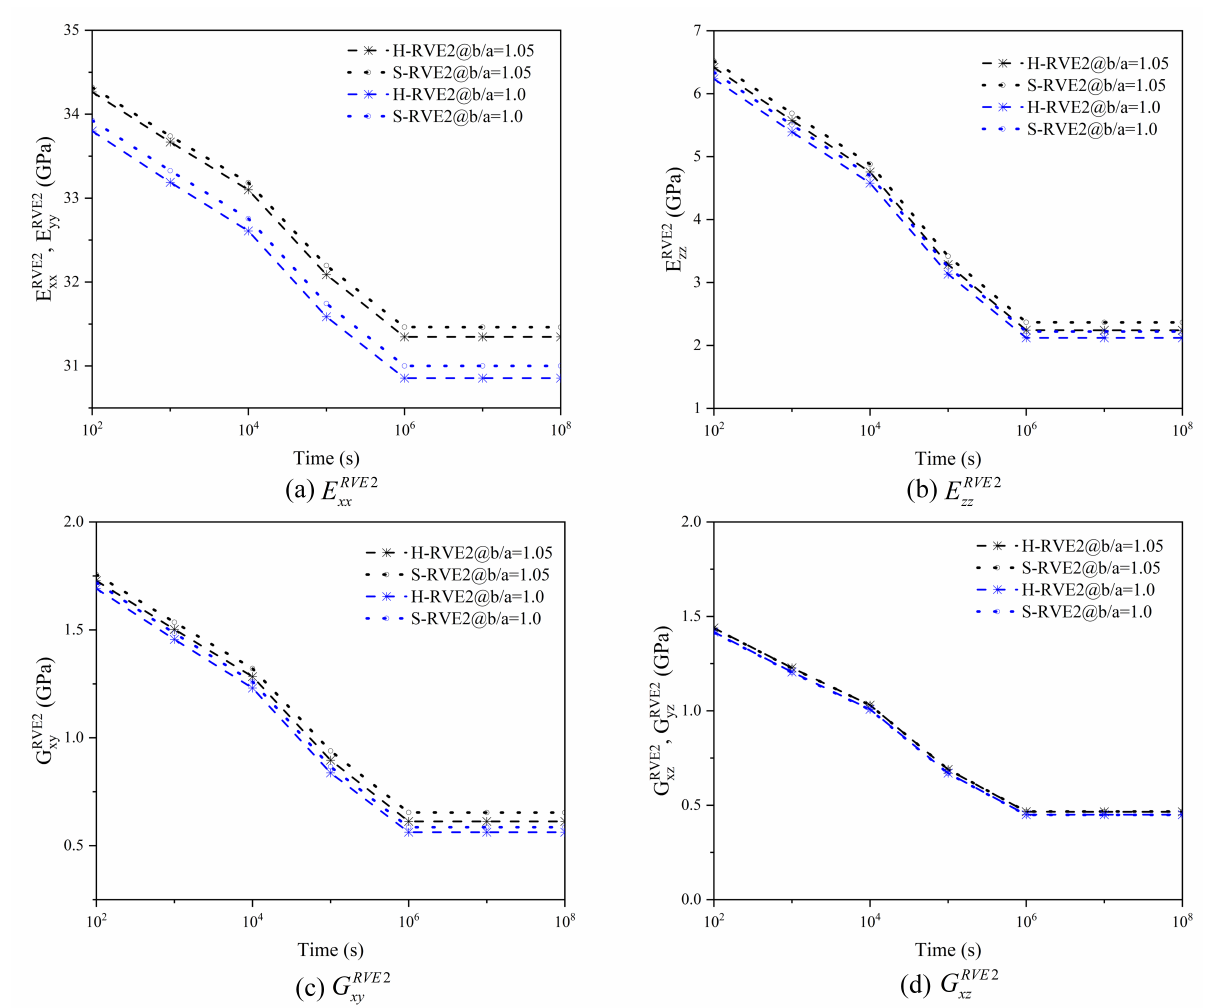
Figure 12.Figure 12. Effect of the coating thickness on effective relaxation stiffness of the yarn.